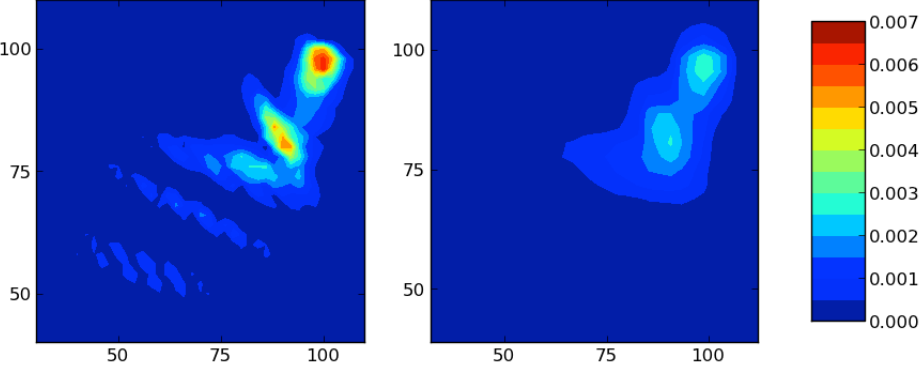
Figure 1. Concentration (ppm) arising from source in a single 3 × 3km grid cell sampled according to the simple column-integrated (left) or instrumental (right) observation operator. The source has an emission rate of 1kgCm 2 year − 1 . Concentration is sampled after continuous emissions for 6h. The source has dimension 3km × 3km and is centered at x = y = 101.5km. The 200km × 200km domain is centered at the location of Shanghai (31.2 ◦ N, 131.5 ◦ E). We plot only the southwest part of the domain.